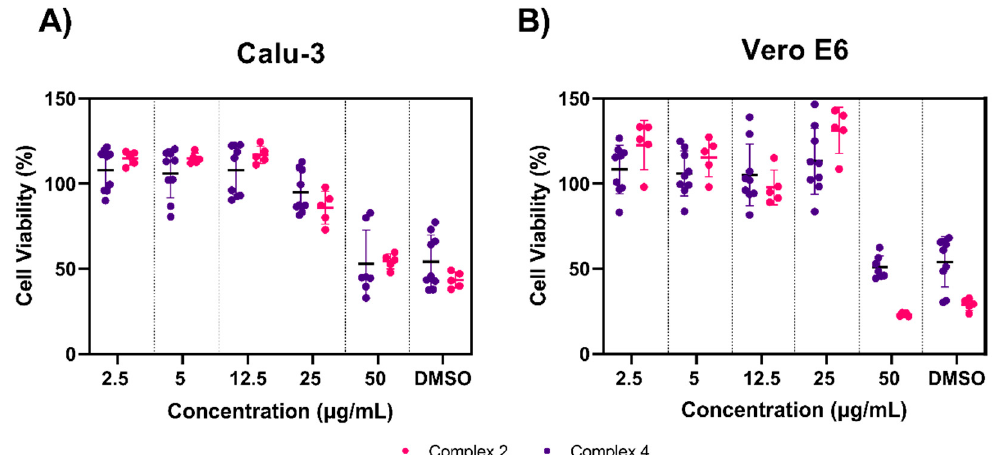
Figure 5. Cytotoxicity of Complexes 2 and 4. Cell viability was measured by MTS assay in ( A ) Calu-3 and ( B ) Vero E6 cell lines. Complex 2 and 4 were made in complete cell medium at concentrations ranging from 2.5–50 µg/mL and allowed to incubate with cells for 24 h before assessing viability. All MTS values were normalized to the control (untreated cells). No statistical differences were observed between concentrations of 50 µg/mL and the DMSO control. All other concentrations were significantly greater than the DMSO controls, **** p < 0.0001. Data are shown from experiments conducted in quadruplicate or quintuplicate wells. Horizontal bars represent the mean and error bars represent the standard deviation.